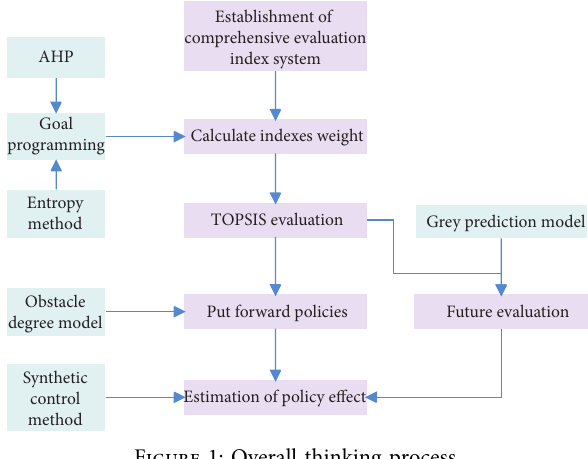
Figure 1: Overall thinking in Figure 2. The data of all indicators are from the World Bank database.